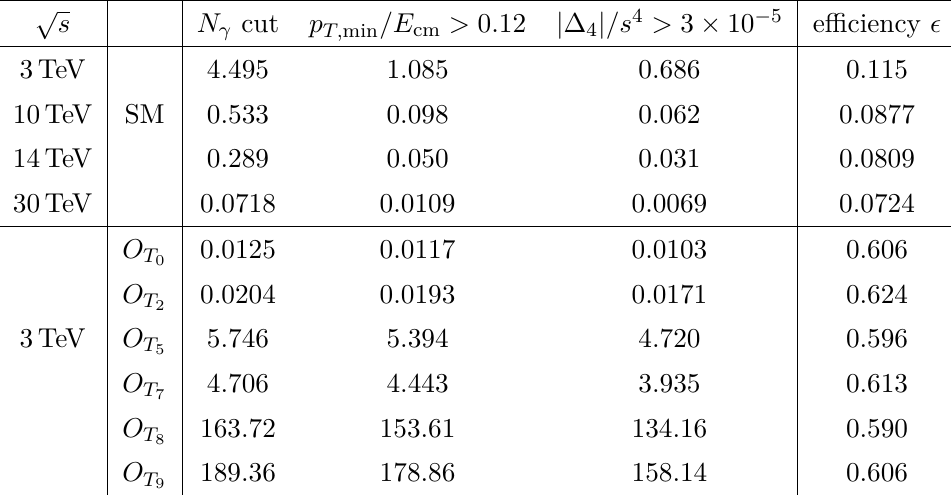
√ s , where ˆ σ int is defined in eq.